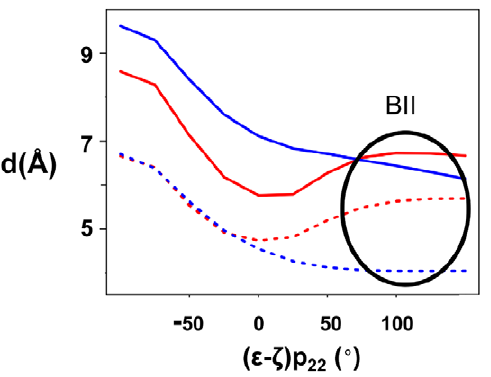
Figure 6. Effect of p 22 conformational state on Mg 2 + -p 22 A 22 distances. The distances between the OP2 and O3 9 atoms of p 22 and A 22 (d(O2P(p 22 )-N7(A 22 )), indicated by a dashed red line; (d(O3 9 (p 22 )- N7(A 22 ) by a dashed blue line) depend on the conformational state of p 22 , represented here by ( e - f ) p 22 values. When Mg 2 + interacts with A 22 and G 23 , d(Mg 2 + -O2P(p 22 )) (red) and d(Mg 2 + -O3 9 (p 22 )) (blue) are parallel to d(O2P(p 22 )-N7(A 22 )) and d(O3 9 (p 22 )-N7(A 22 ), respectively. The standard deviations for distances are 1.2 A˚. The distances were examined on the two groups of structures defined in Figure 5 caption.